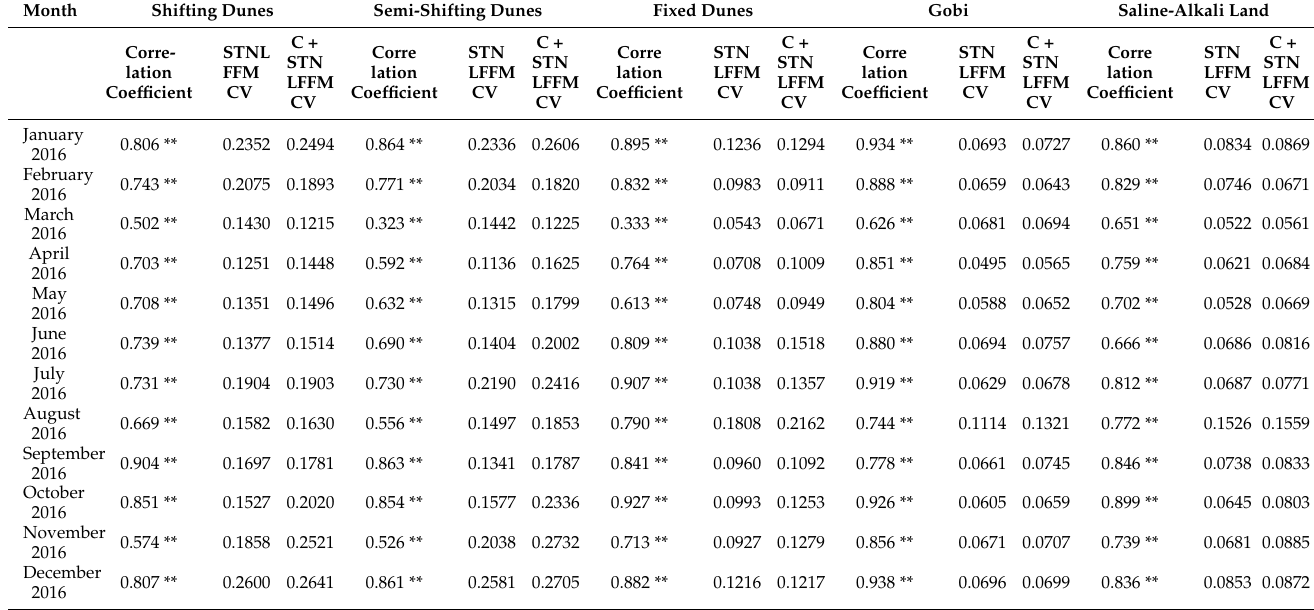
Table 3. The inter-monthly correlation coefficients between STNLFFM surface albedo and C + STNLFFM surface albedo over shifting dunes, semi-shifting dunes, fixed dunes, the Gobi, and saline- alkali land, and the surface albedo coefficients of variation of shifting dunes, semi-shifting dunes, fixed dunes, the Gobi, and saline-alkali land based on STNLFFM and C +